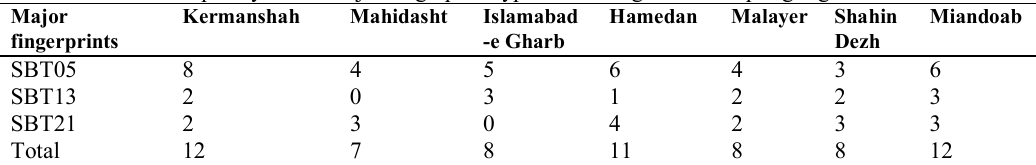
Table 3. Relative frequency of the major fingerprint types according to the sampling regions.